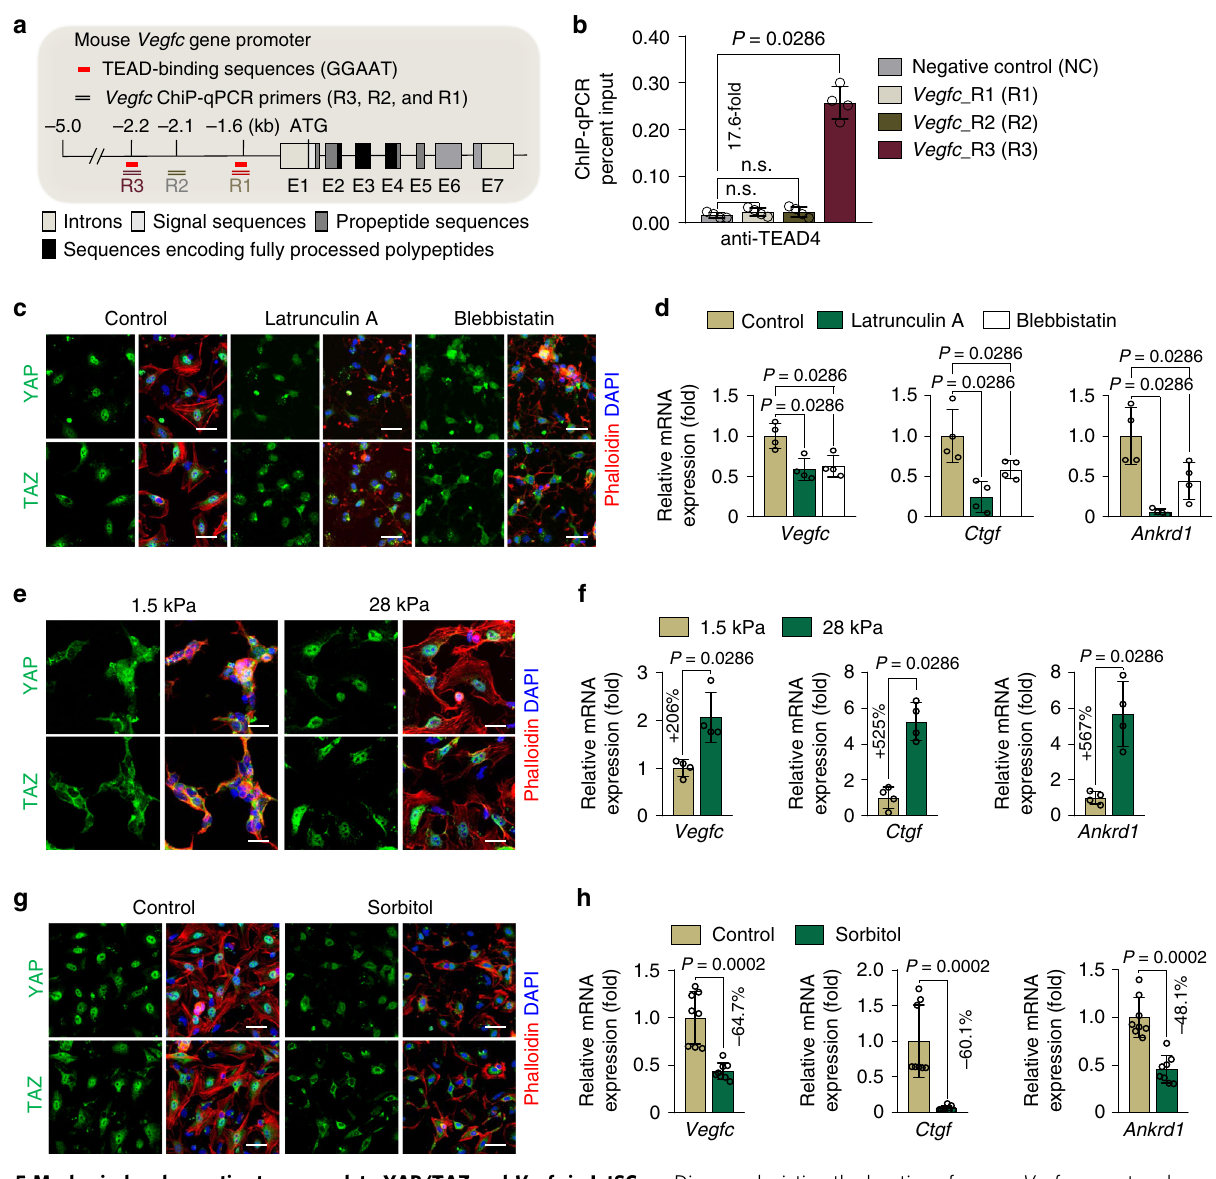
Fig. 5 Mechanical and osmotic stress regulate YAP/TAZ and Vegfc in IntSCs. a Diagram depicting the location of mouse Vegfc promoter element upstream of the transcription start site (ATG) relative to the Vegfc gene with presence and arrangement of consensus TEAD-binding sequences (GGAAT, red lines). ChIP-qPCR primers of Vegfc gene promoter around the TEAD-binding sequences are depicted as R1, R2 or R3. b ChIP-qPCR in MEFs indicating the endogenous interaction between TEAD and the Vegfc promoter located − 2.2 kb upstream of the transcription start site of Vegfc gene. Dots indicate values from four independent experiments, and horizontal bars indicate mean ± SD. P value versus negative control (NC) by two-tailed Mann – Whitney U test. n.s., not signi fi cant. c , d Representative images of YAP and TAZ and comparison of mRNA expressions of Vegfc , Ctgf , and Ankrd1 in isolated IntSCs after treatment with control (DMSO), latrunculin A (1 μ M), or blebbistatin (50 μ M) for 6 h. Similar results were observed in four independent experiments. Scale bars, 50 μ m. Dots indicate data from four independent experiments and horizontal bars indicate mean ± SD. P value versus control by two-tailed Mann – Whitney U test. e , f Representative images of YAP and TAZ and comparison of mRNA expressions of Vegfc , Ctgf and Ankrd1 in isolated IntSCs plated on 1.5 kPa and 28 kPa matrix. Similar results were observed in four independent experiments. Scale bars, 20 μ m. Dots indicate data from four independent experiments and horizontal bars indicate mean ± SD. P value versus 1.5 kPa matrix by two-tailed Mann – Whitney U test. g , h Representative images of YAP and TAZ and comparison of mRNA expressions of Vegfc , Ctgf and Ankrd1 in isolated IntSCs with or without 0.4 M sorbitol-induced osmotic stress for 3 h. Similar results were observed in four independent experiments. Scale bars, 50 μ m. Dots indicate data from eight independent experiments and horizontal bars indicate mean ± SD. P value versus Control by two-tailed Mann – Whitney U